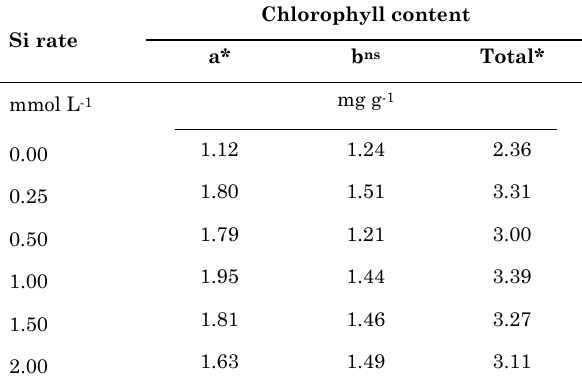
Table 3. Photosynthetic pigment content as a function of silicon (Si) application rates in maize plants grown in a nutrient solution with arsenic Si